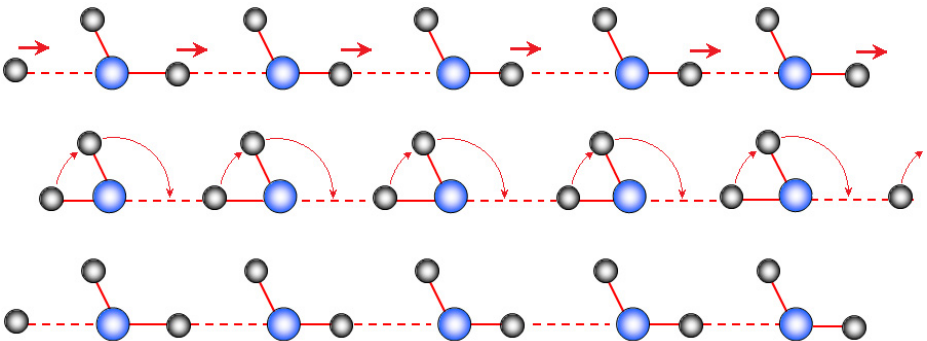
Figure 3. Scheme of proton transfer along the model chain of hydrogen bonds.